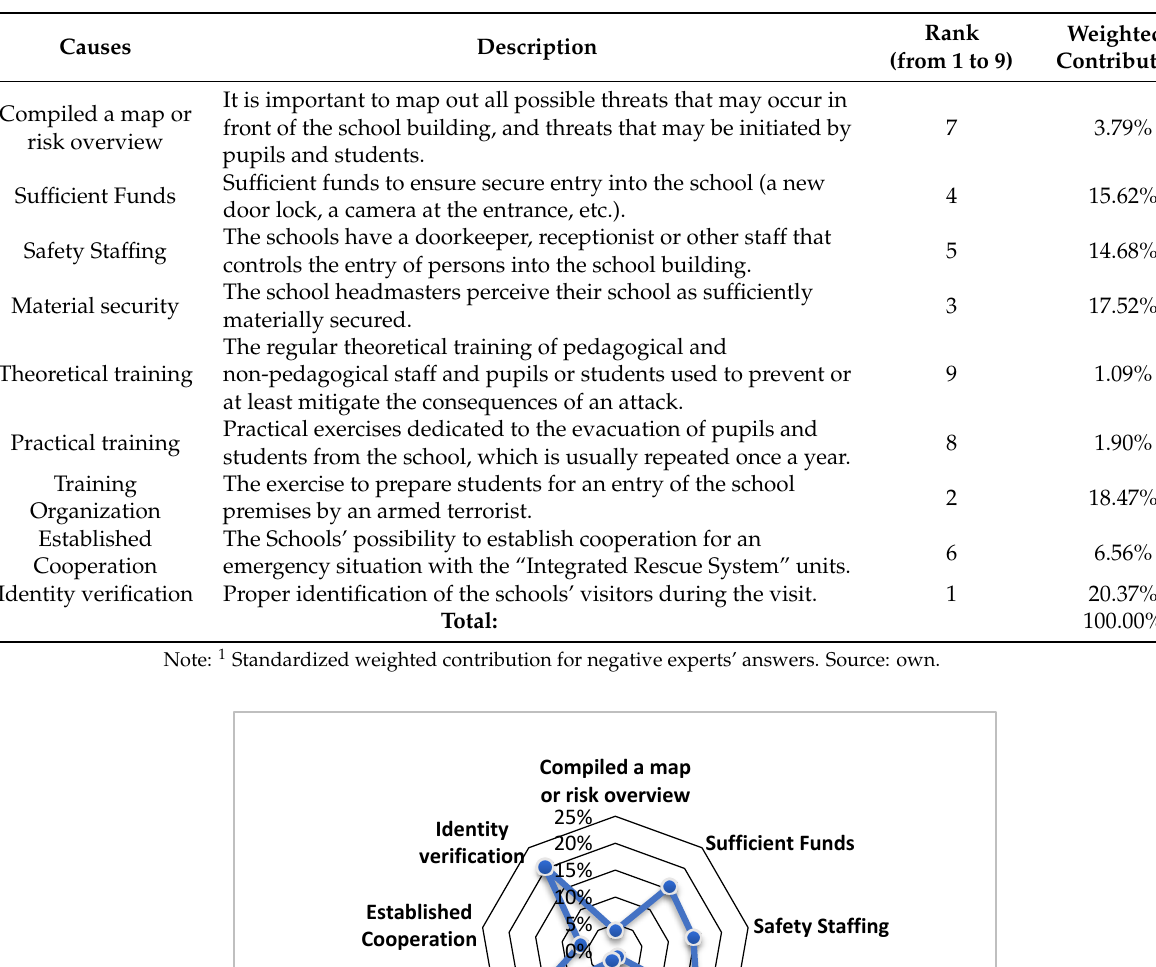
Table 8. Possible causes that may reduce the schools’ safety.